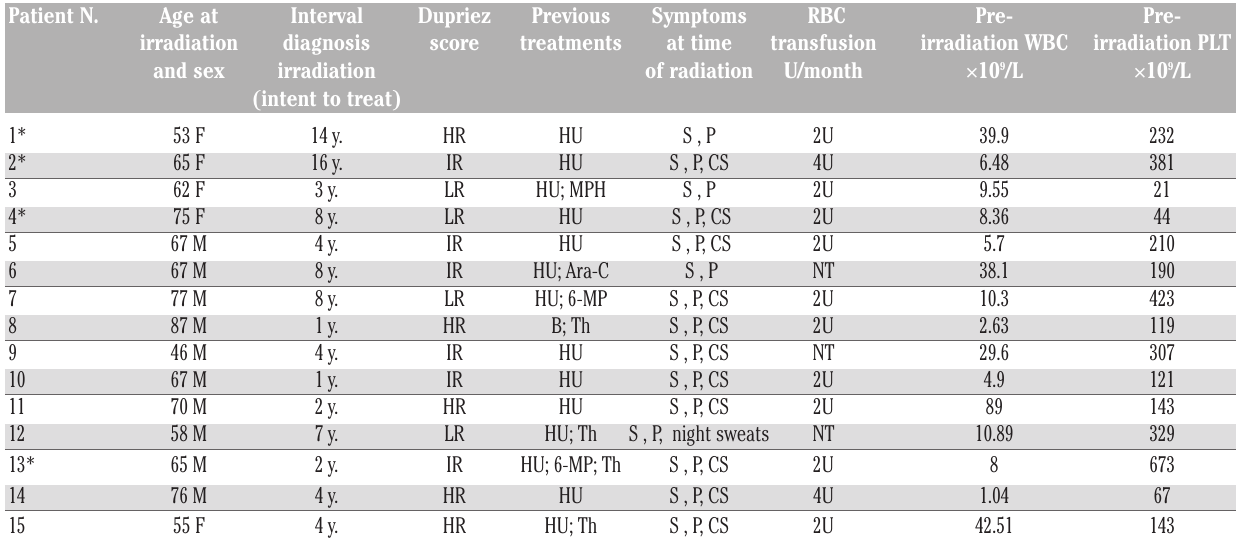
Table 1. Patients’ characteristics at the time of first irradiation. Patient